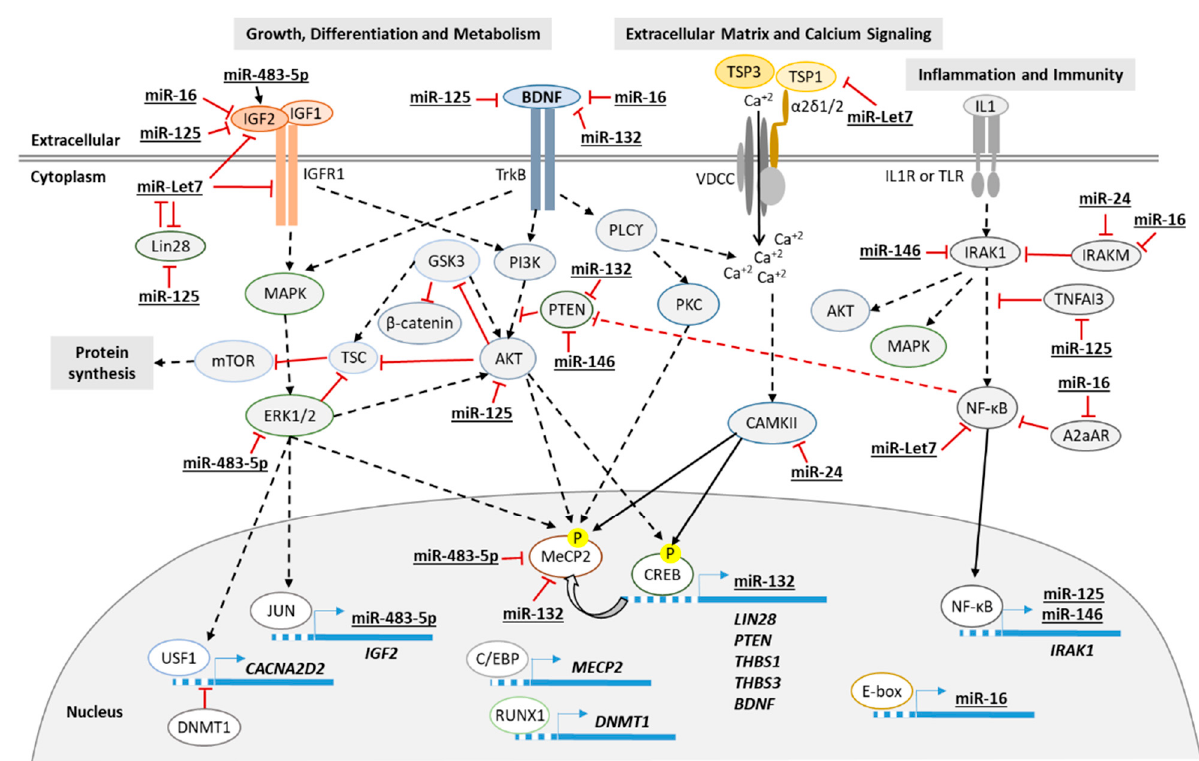
Figure 5. Diagram of the proposed principal signaling pathways involved in RTT. Continuous line for direct effect and dotted line for multistep signaling.